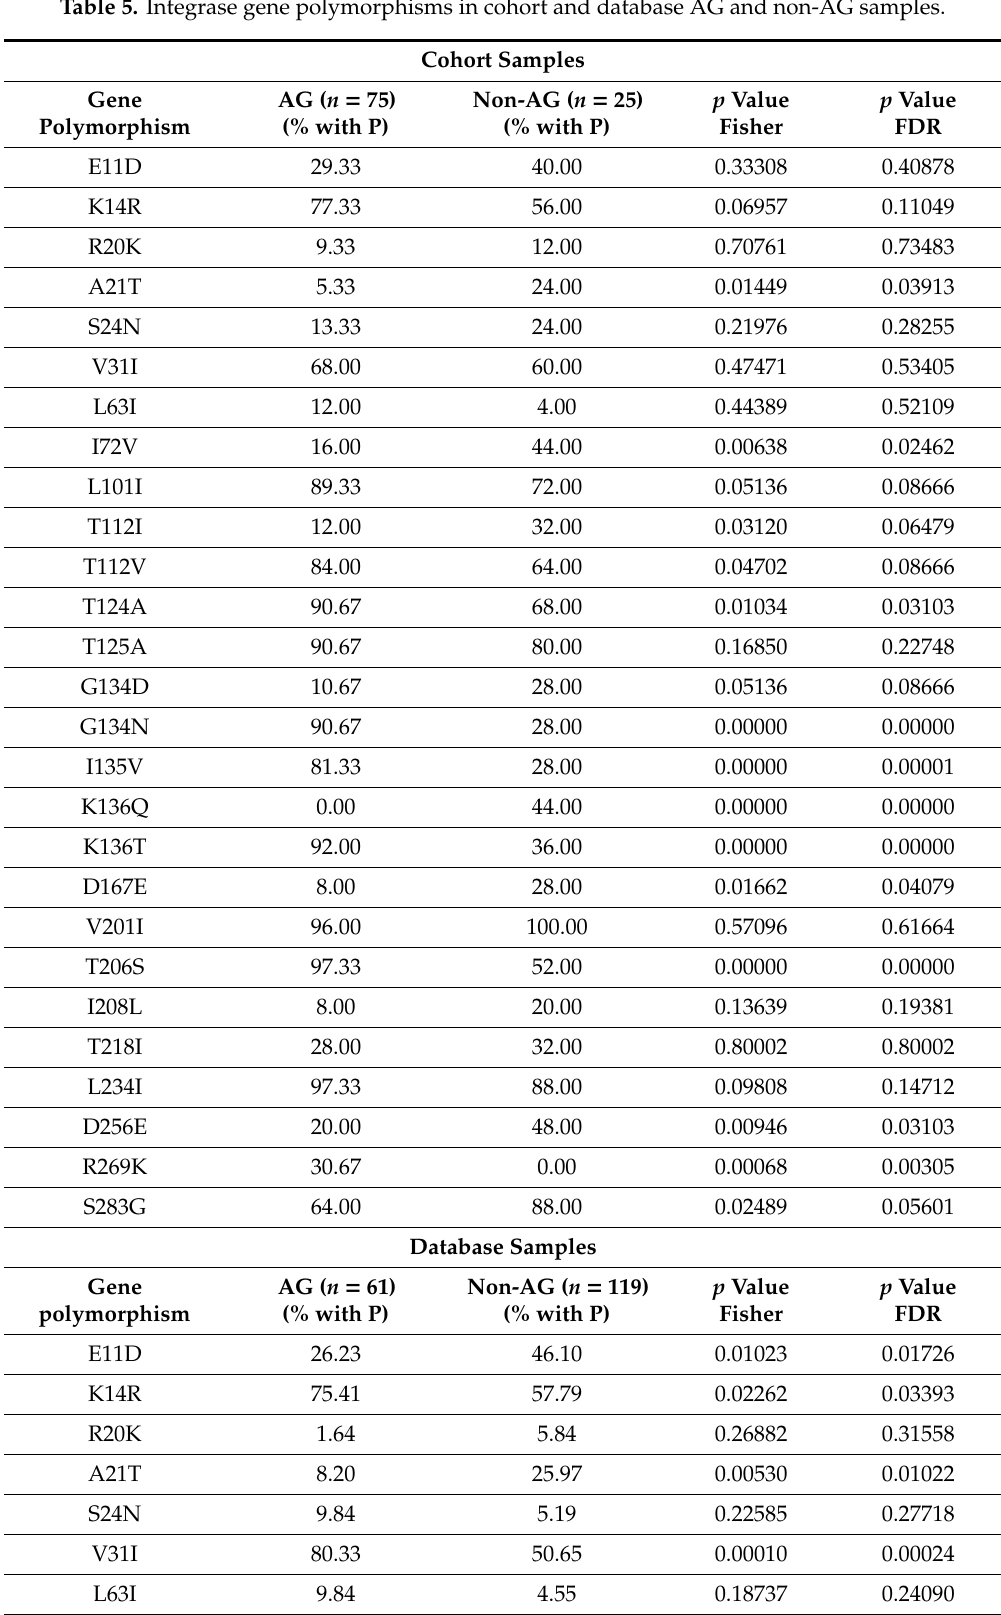
Table 5. Integrase gene polymorphisms in cohort and database AG and non-AG samples. Cohort